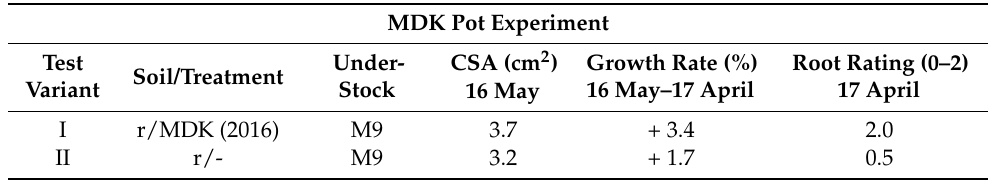
Table 7. MDK Pot Experiment-effect of MDK on tree vigour.